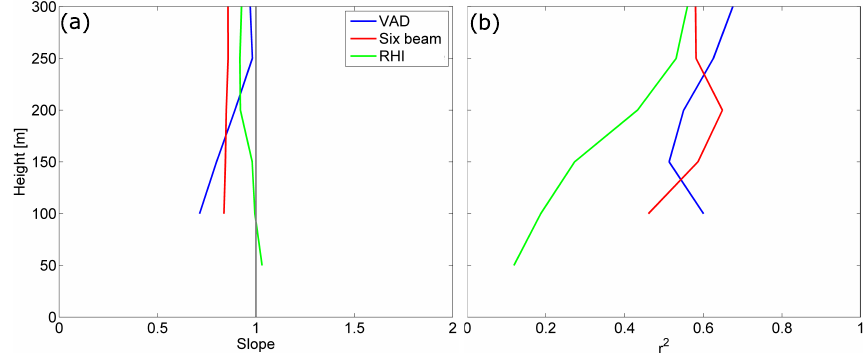
Figure 10. Same as Fig. 6 but for TI instead of TKE.